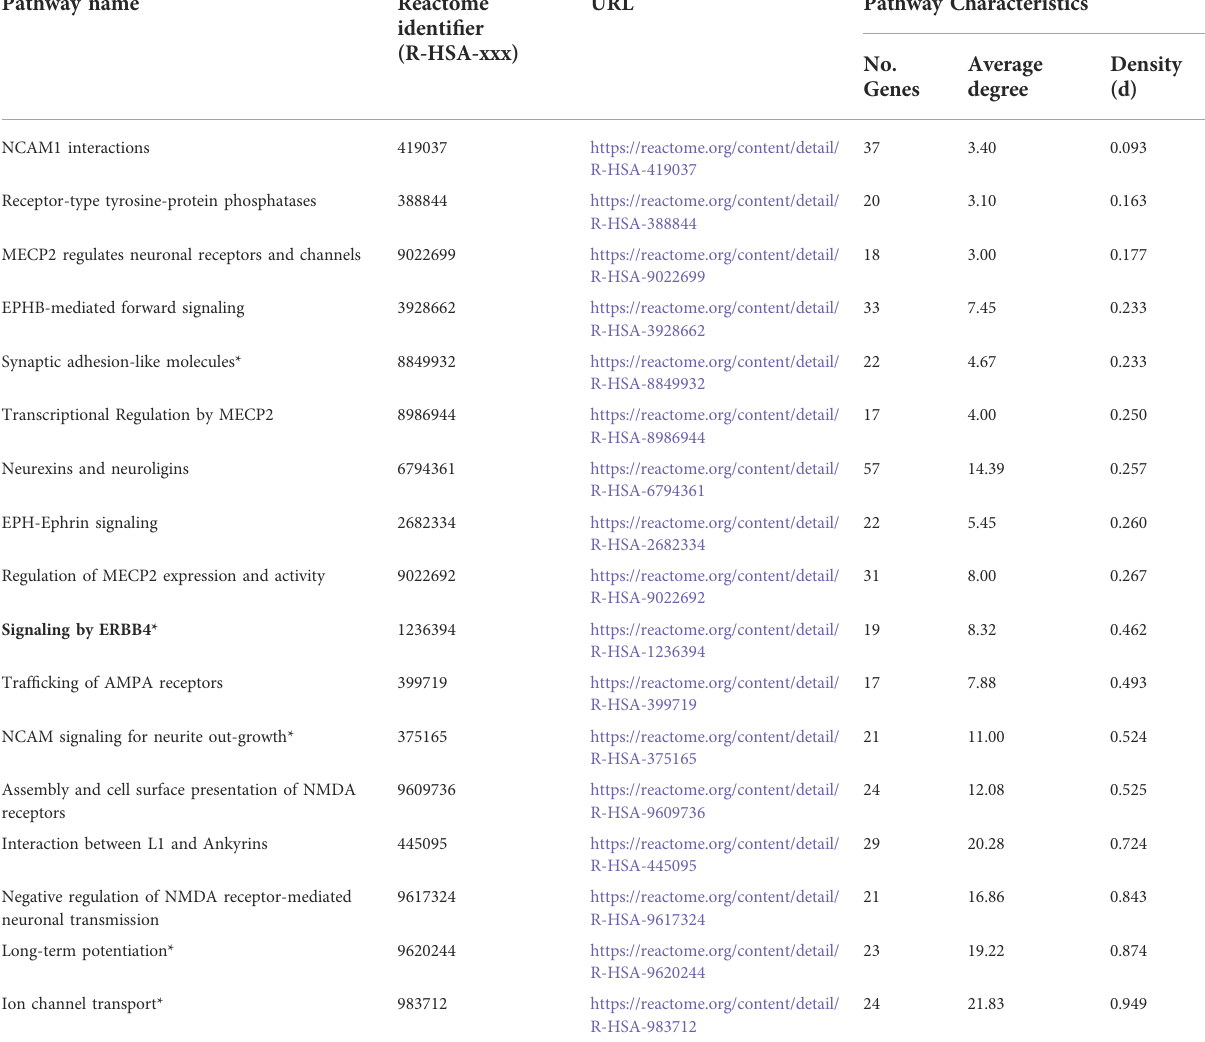
TABLE 2 Selected pathways investigated in the real-data